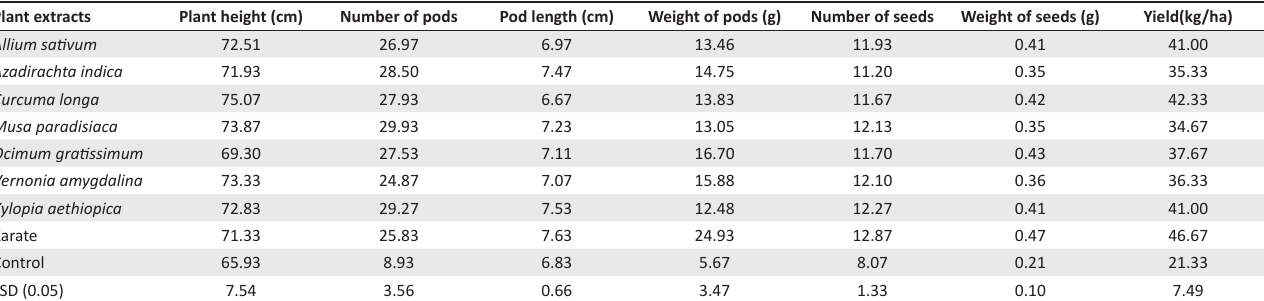
TABLE 5: Effect of selected plant extracts and karate on yield and yield components of mung bean in 2016 cropping season. Plant extracts Plant height